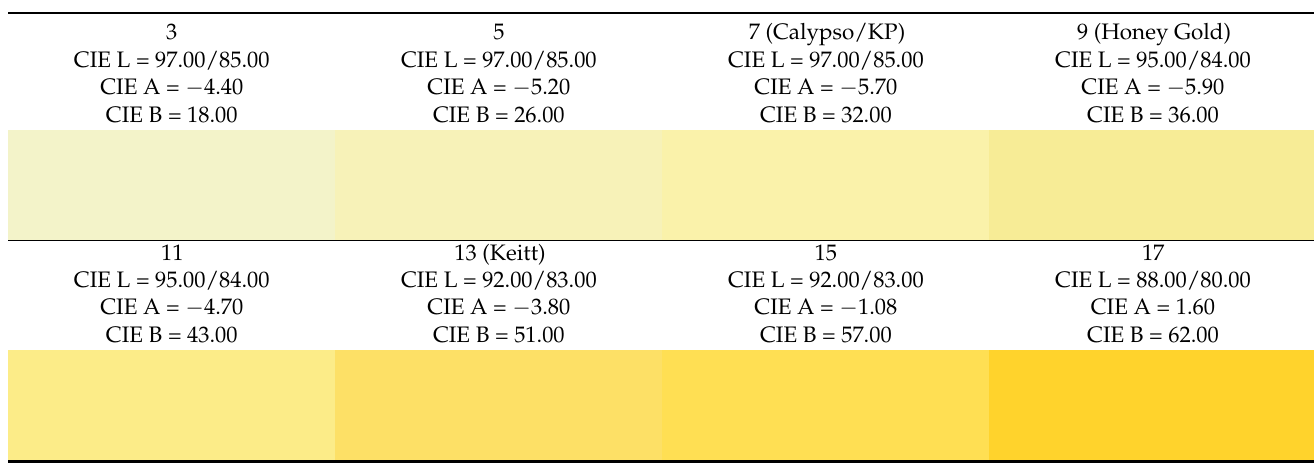
Table A3. Proposed fruit maturity colour swatches and associated CIE LAB values, with maturity targets specific to cultivar. CIE L have two proposed values separated by slash (/), the first for printing purposes based on use of a PDF document, the second being the expected CIE L reading of fruit